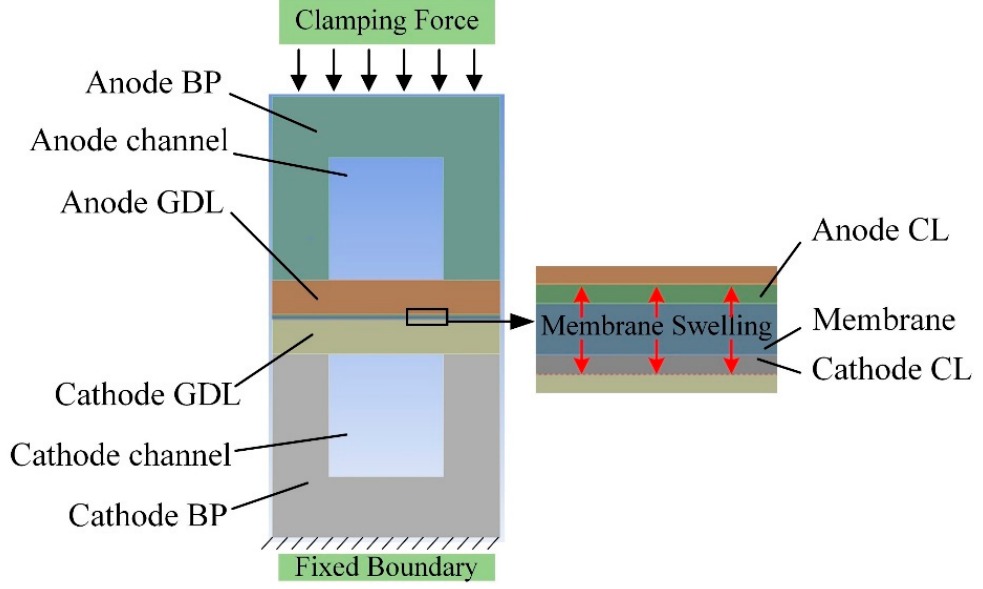
Figure 1. Computational domain of the FEM model.